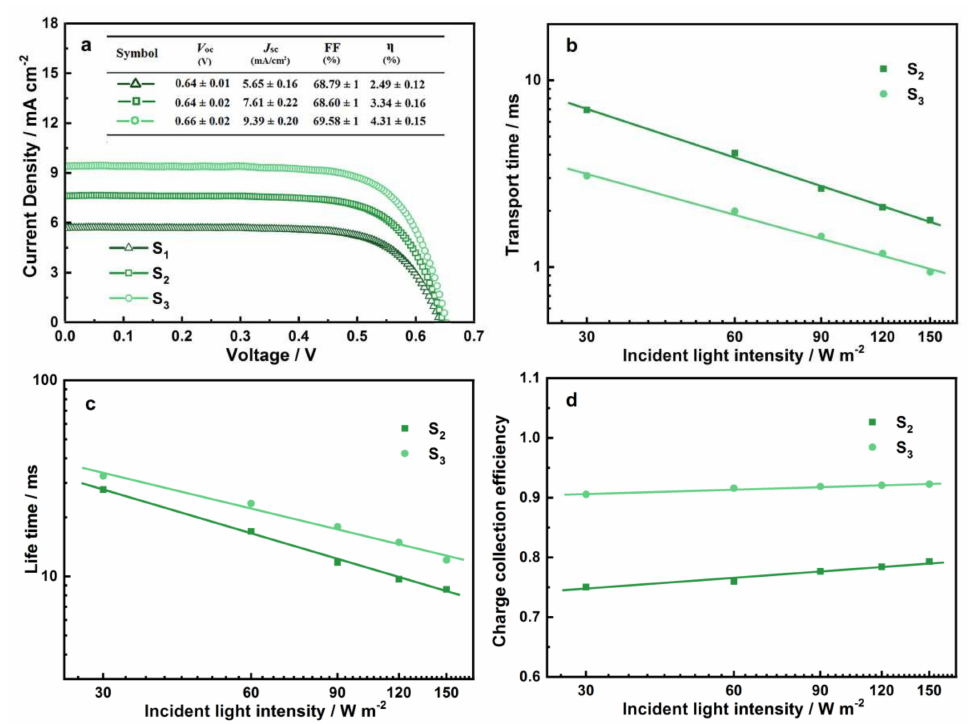
Figure 2. ( a ) J − V curves for the DSSCs based on the different electrodes; ( b ) Transport time, ( c ) Life- time and ( d ) the charge collection efficiency of the different